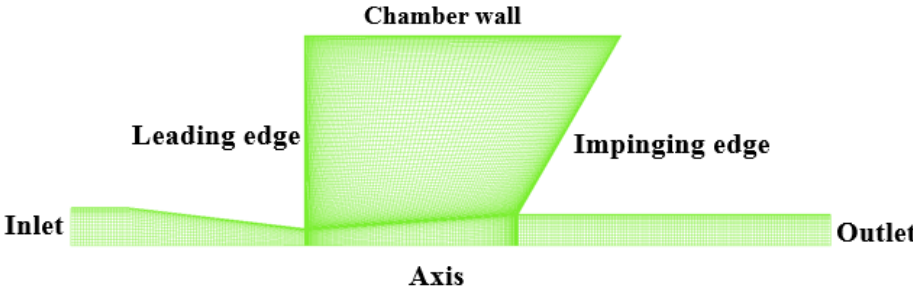
Figure 8. 2D computational axisymmetric domain and boundary conditions.